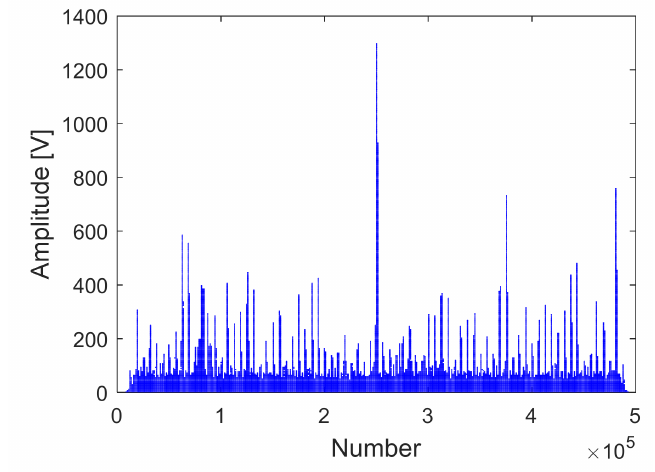
Figure 18. Data error statistics of GPU and